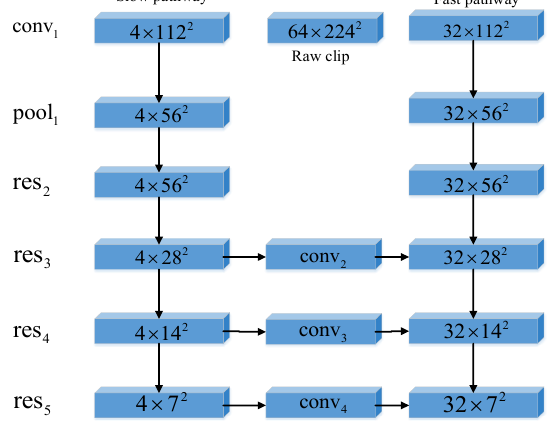
Figure 8. Flowchart of SlowFast CNN for lateral fusion.